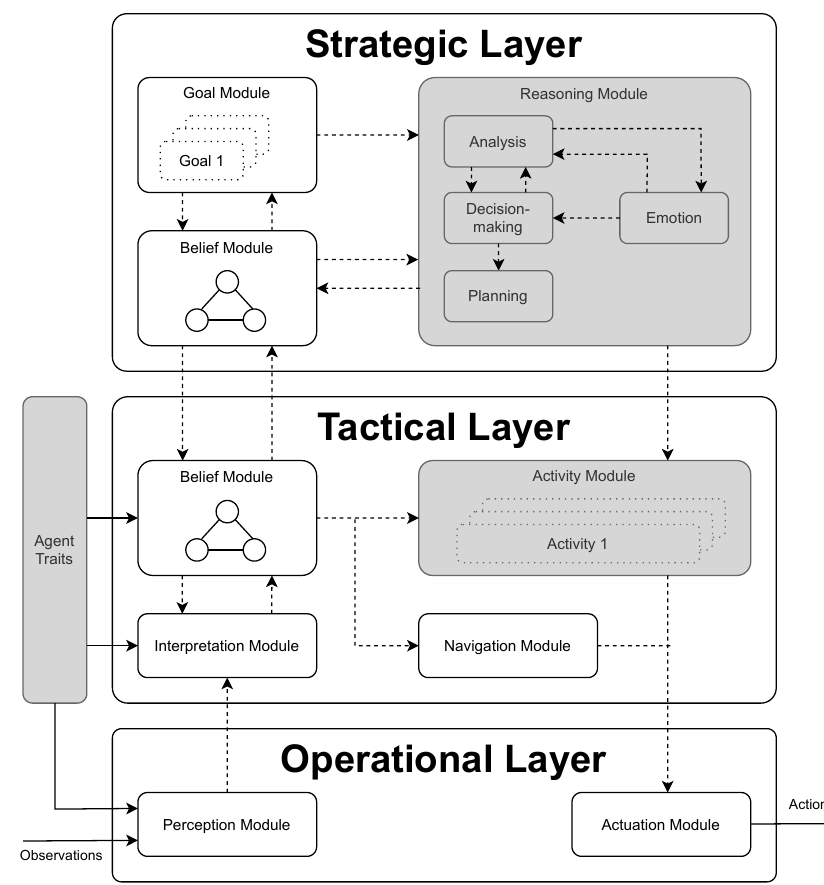
Figure 2. AATOM architecture adapted and improved from